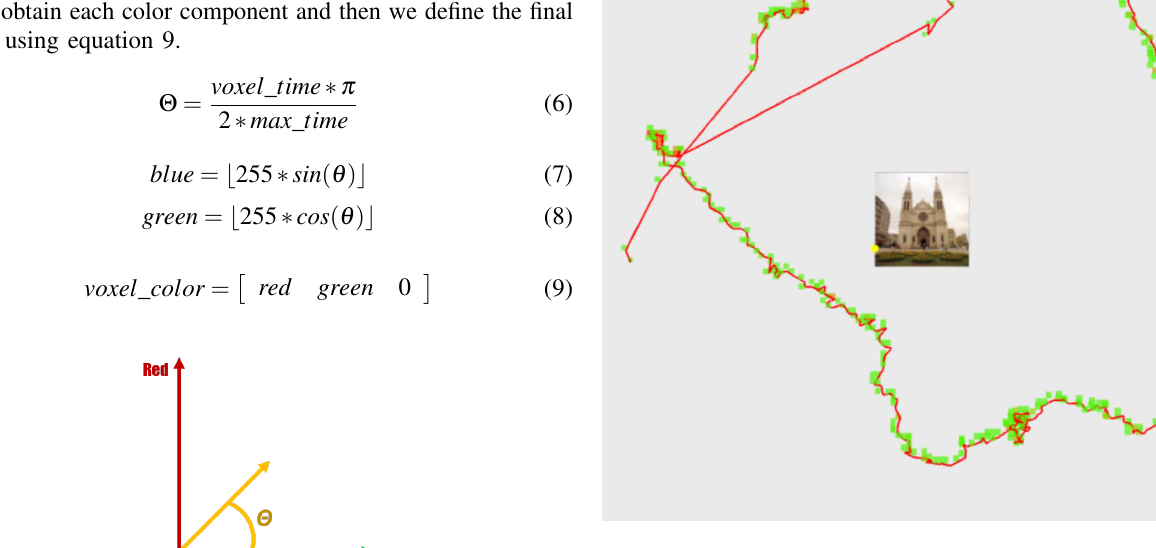
Figure 9. Top view of the camera path, performed by the user while interacting with application, around the marker (in red). The green cubes represent camera positions sampled by the proposed capture